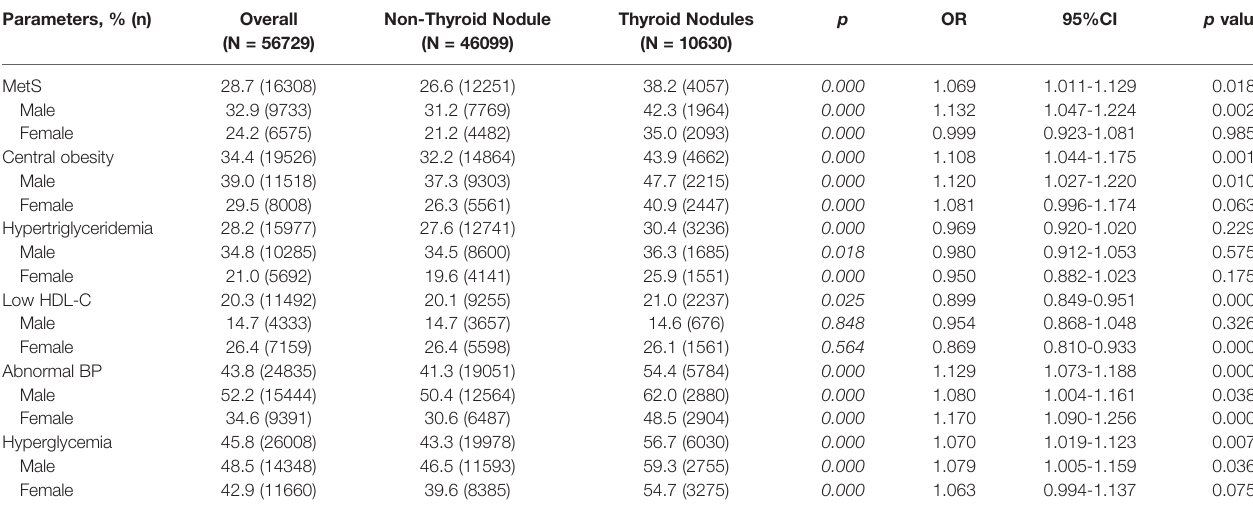
TABLE 1 | Associations between metabolic syndrome and thyroid nodules in TIDE survey. Parameters, % (n) Overall Non-Thyroid Nodule Thyroid